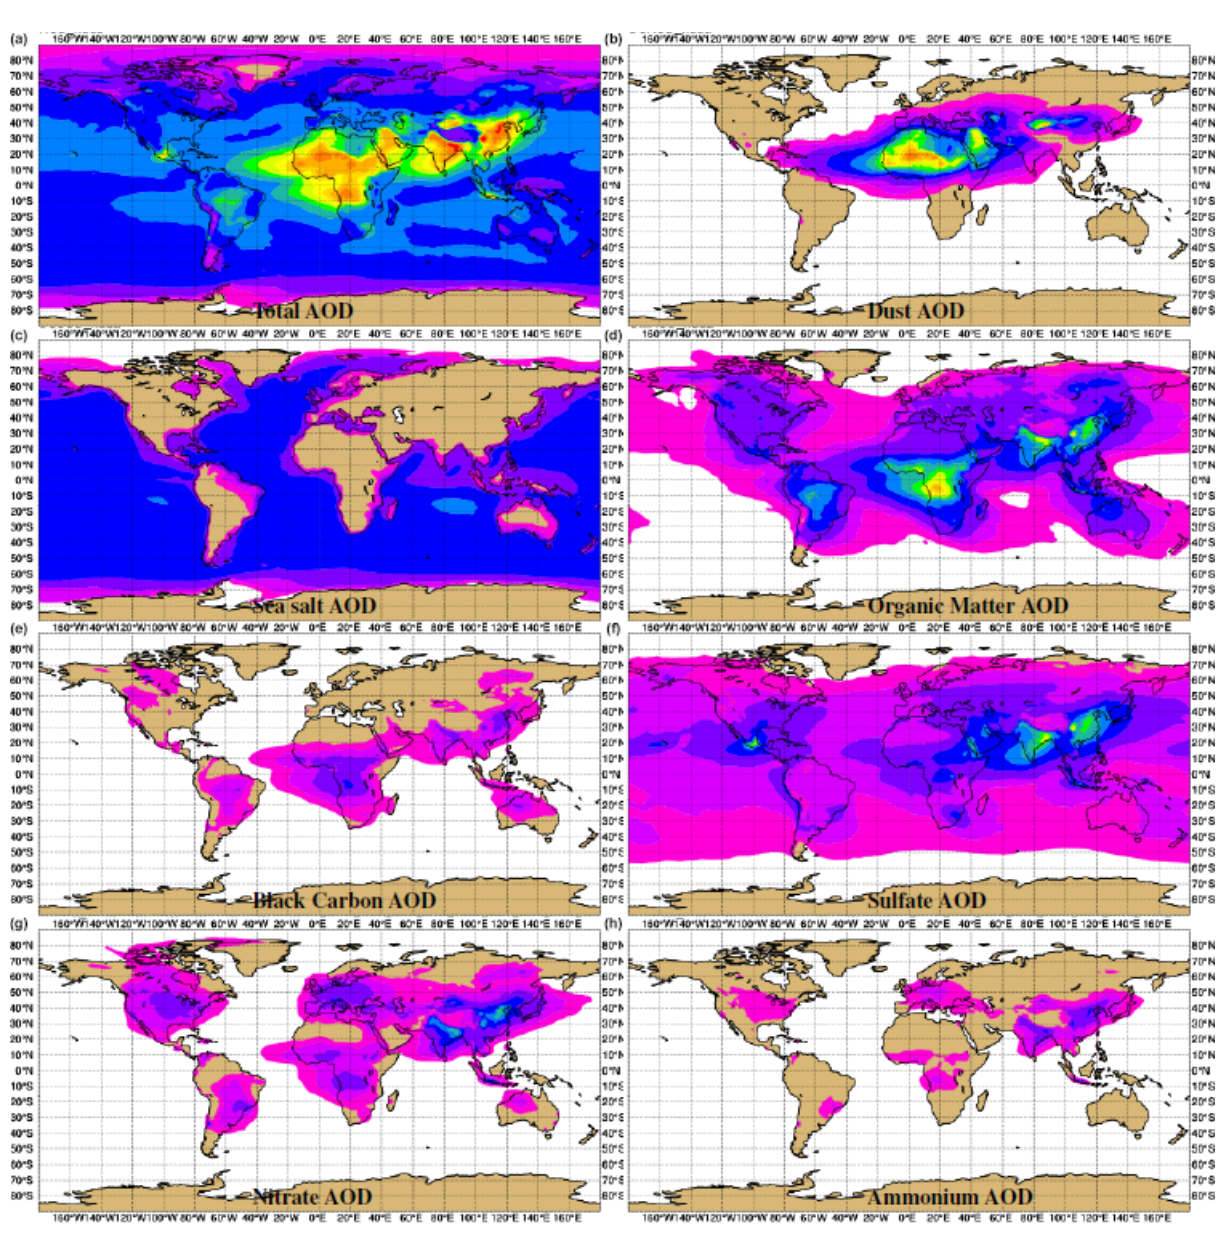
Figure 4. Mean 2017 total (a) , dust (b) , sea salt (c) , OM (d) , BC (e) , sulfate (f) , nitrate (g) and ammonium (h) AOD at 550nm simulated by the CY471_NEWDEP